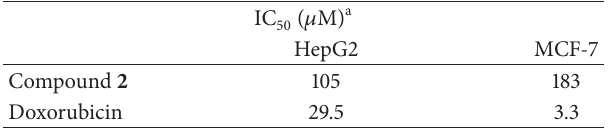
Table 5: In vitro cytotoxic activities of the compound 2 against hepatocellular carcinoma (HepG2) and breast cancer (MCF-7) cell